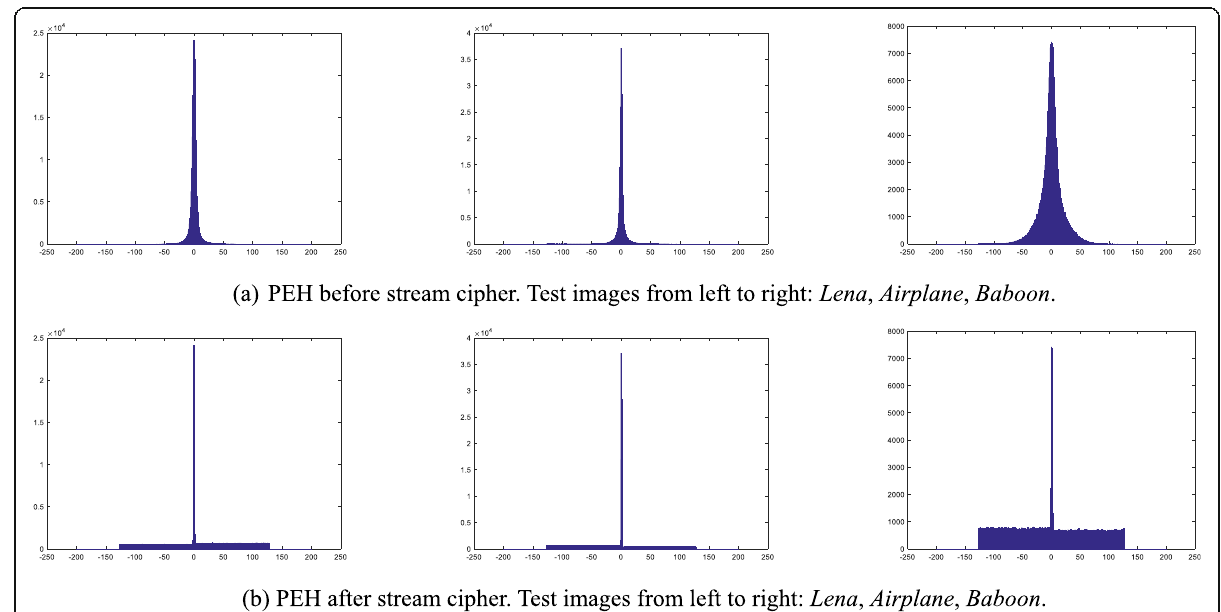
Fig. 3 PEH before and after stream cipher